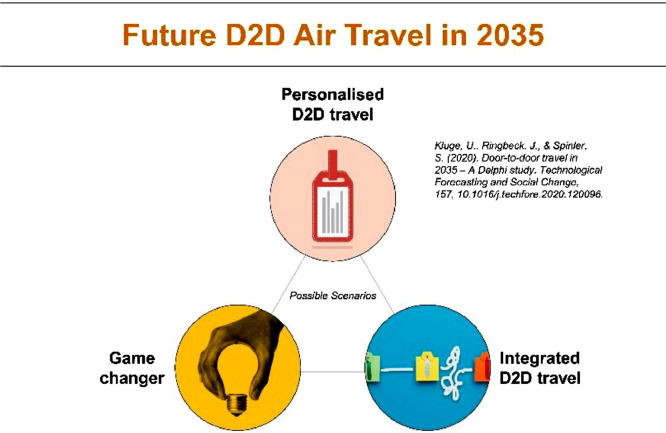
Example of the visualization of scenarios [4].